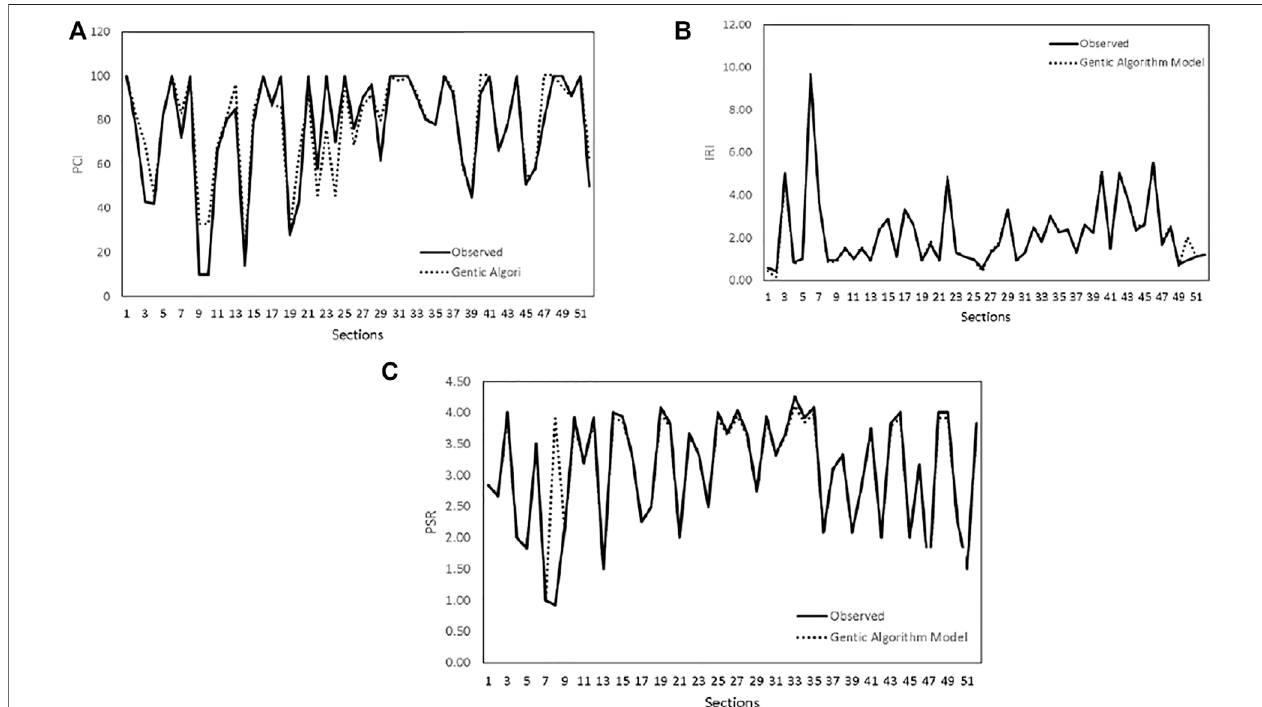
FIGURE 14 | Predicted PCI (A) , IRI (B) , and PSR (C) , respectively, using GEP.